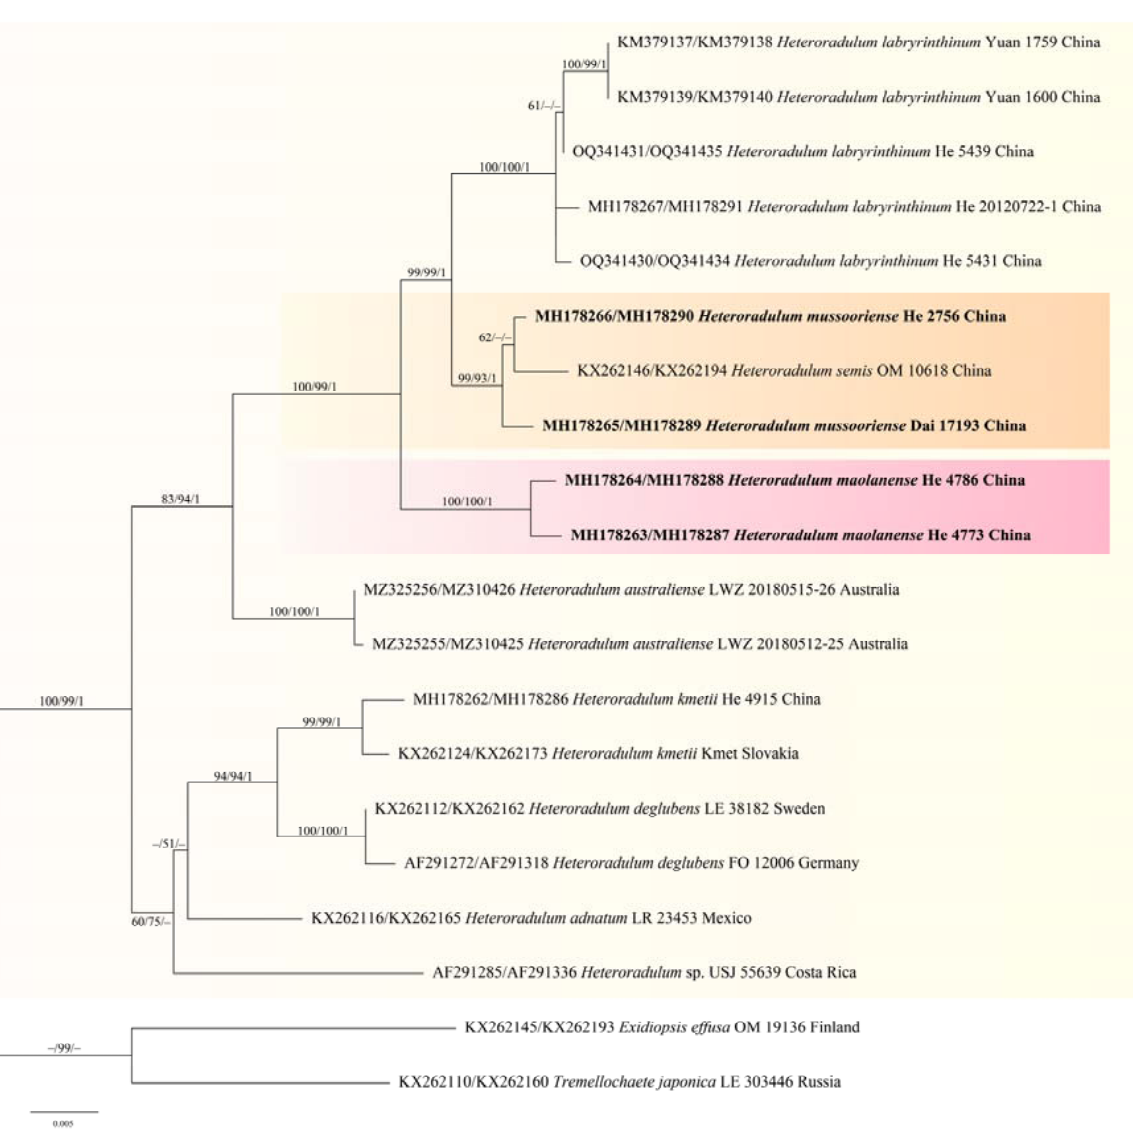
Figure 4. Phylogenetic tree of ML analysis of the concatenated ITS ‐ 28S sequences of Heteroradulum species. Branches are labelled with parsimony bootstrap values ( ≥ 50%, first), likelihood bootstrap values ( ≥ 50%, second), and Bayesian posterior probabilities ( ≥ 0.95, third). New species (pink) and new combinations (orange) are highlighted and set in bold.